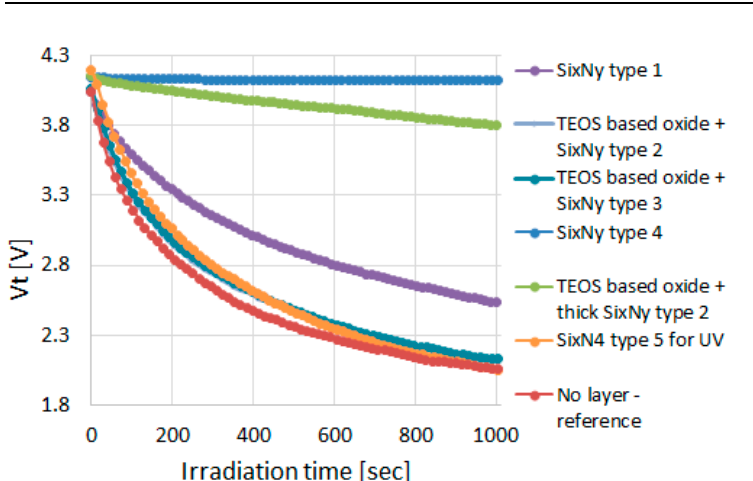
Figure 4. Y-Flash cells Vt change as a result of 255 nm UV irradiation. The effect of various nitride containing layers is evaluated.